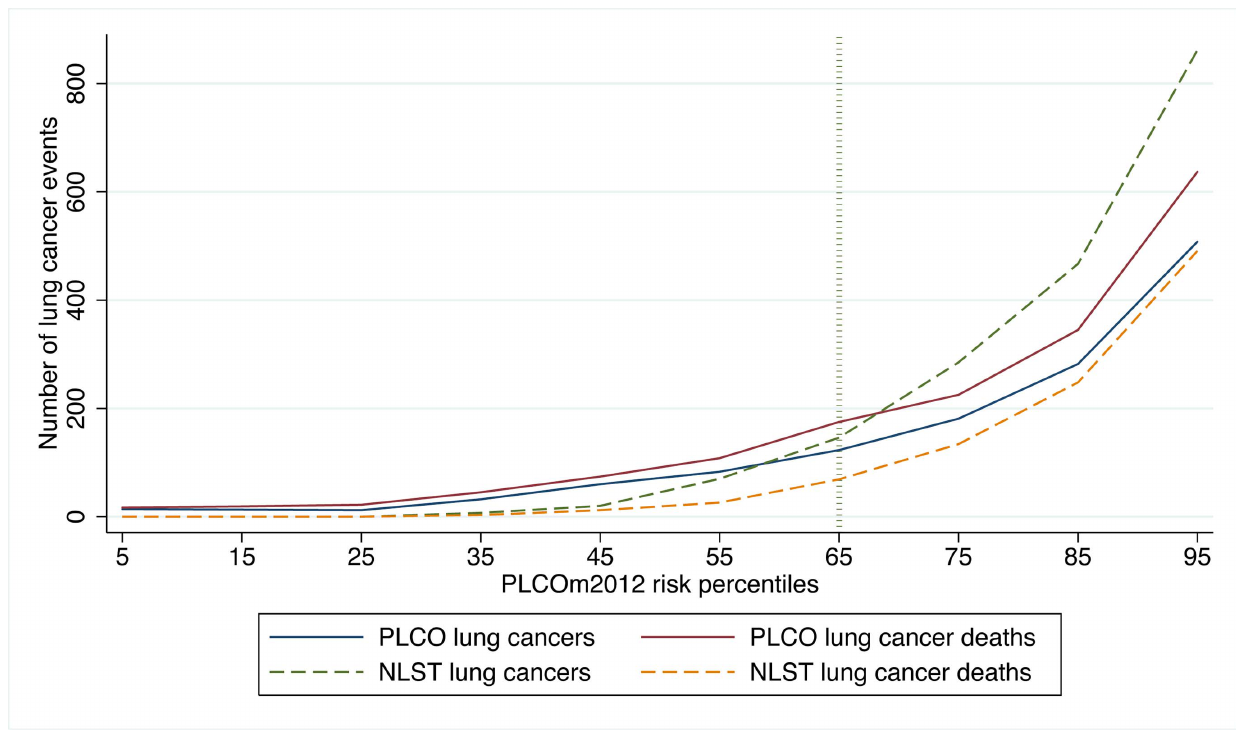
Figure 2. Number of lung cancer cases and deaths in PLCO and NLST by PLCO m2012 percentiles of risk. PLCO and NLST lung cancer cases and NLST lung cancer deaths were identified in 6 y of follow-up, and PLCO lung cancer deaths were identified in 11 y of follow-up. Calculations were based on PLCO m2012 deciles of risk, and the percentiles shown are the midpoints of each decile range. PLCO m2012 refers to the lung cancer risk prediction model described in